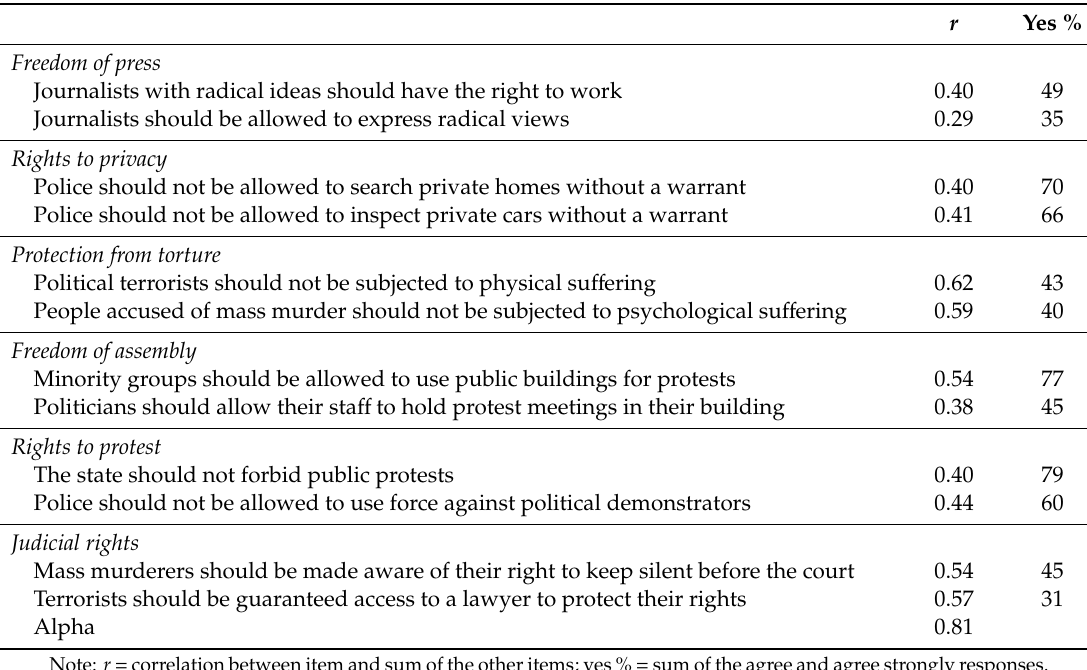
Table 1. Scale of attitude toward civil rights.